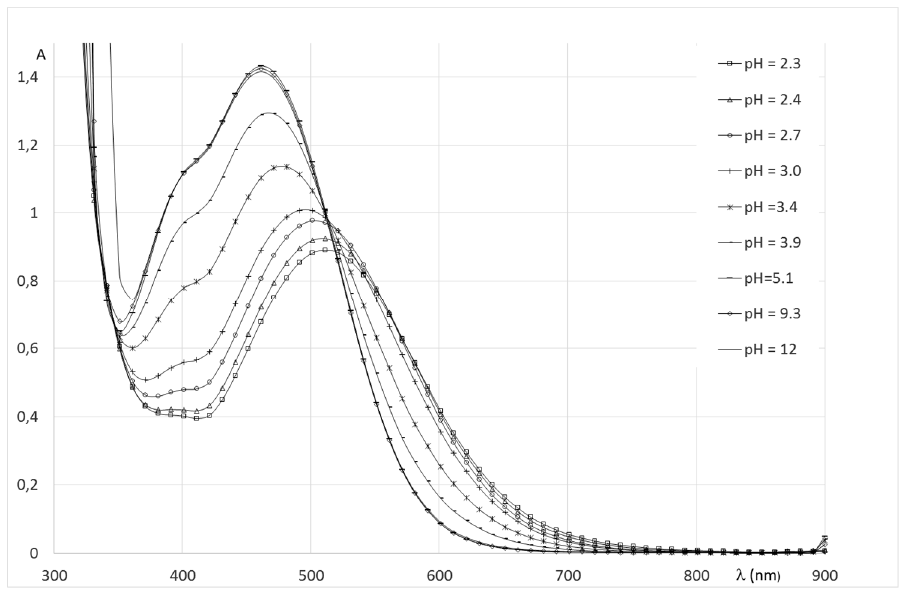
Figure 7. Spectrophotometric titration of Fe(III)- 2 solutions.